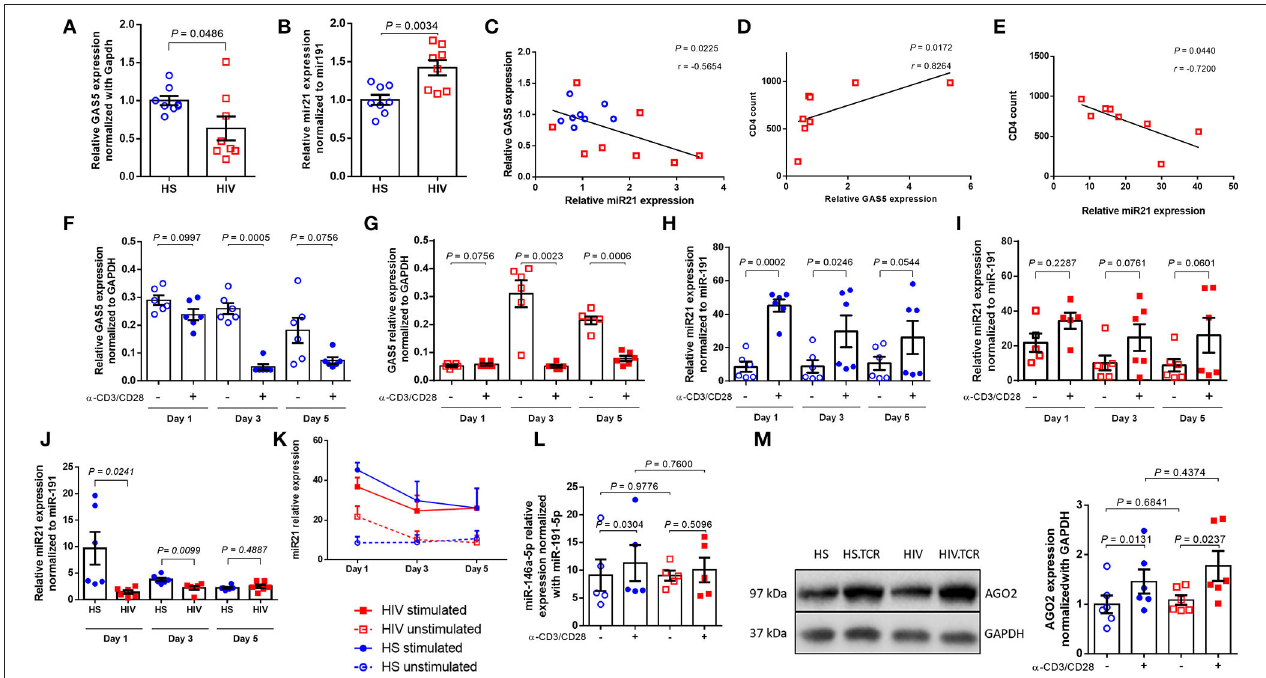
FIGURE 1 | Differential expression of GAS5 and miR-21 in CD4T cells after TCR stimulation. (A,B) Relative expression of GAS5 ( n = 8) and miR-21 ( n = 8) in CD4T cells isolated from HS and PLHIV was determined by RT-qPCR. (C) Correlation between GAS5 and miR-21 expressions in CD4T cells isolated from HS or PLHIV was determined by Pearson correlation analysis. (D,E) Correlation between CD4T cell counts and relative GAS5 ( n = 8) or miR-21 ( n = 8) expressions in CD4T cells from PLHIV was determined by Pearson Correlation analysis. (F,G) Relative expression of GAS5 in CD4T cells from HS and PLHIV in the absence or presence of TCR stimulation for 1, 3, and 5 days ( n = 6). (H,I) Relative expression of miR-21 in HS and PLHIV CD4T cells with or without TCR stimulation for 1, 3, and 5 days ( n = 6). (J) Relative expression of miR-21 in TCR-stimulated CD4T cells from HS and PLHIV in 1, 3, and 5 days ( n = 6). (K) Kinetic changes in miR-21 expression in CD4T cells from both PLHIV and HS following TCR stimulation for 1, 3, and 5 days. (L) Relative expression of miR-146a in CD4T cells from HS and PLHIV with or without TCR stimulation for 24h ( n = 6). (M) Representative dot blot and relative expression of AGO2 (a major component of RISK complex) in CD4T cells from HS and PLHIV with or without TCR stimulation for 24h, determined by Western blotting ( n = 6).